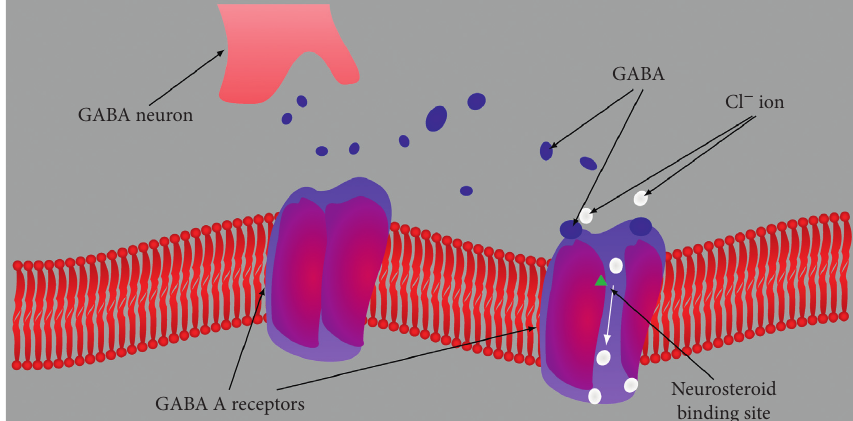
Figure 2: An image of a GABA A receptor, closed left image and open right image to ions, and its GABA and neurosteroid ligand/hormone binding sites. Extrasynaptic GABA A receptors primarily contribute to tonic inhibition. Neurosteroids, including progesterone, allo- pregnanolone, and DHEA, activate both postsynaptic and extrasynaptic receptors to enhance the phasic and tonic inhibition and thereby promote maximal net inhibition. The blue dots represent the GABA neurotransmitter molecules released from the vesicles of the GABA neuron synapse; the white dots represent chloride ion movement through the GABA A receptor. Abbreviations: GABA, c -aminobutyric acid; DHEA, dehydroepiandrosterone; DHEAS, dehydroepiandrosterone sulfate; CL ion, Cl − ion. [35].